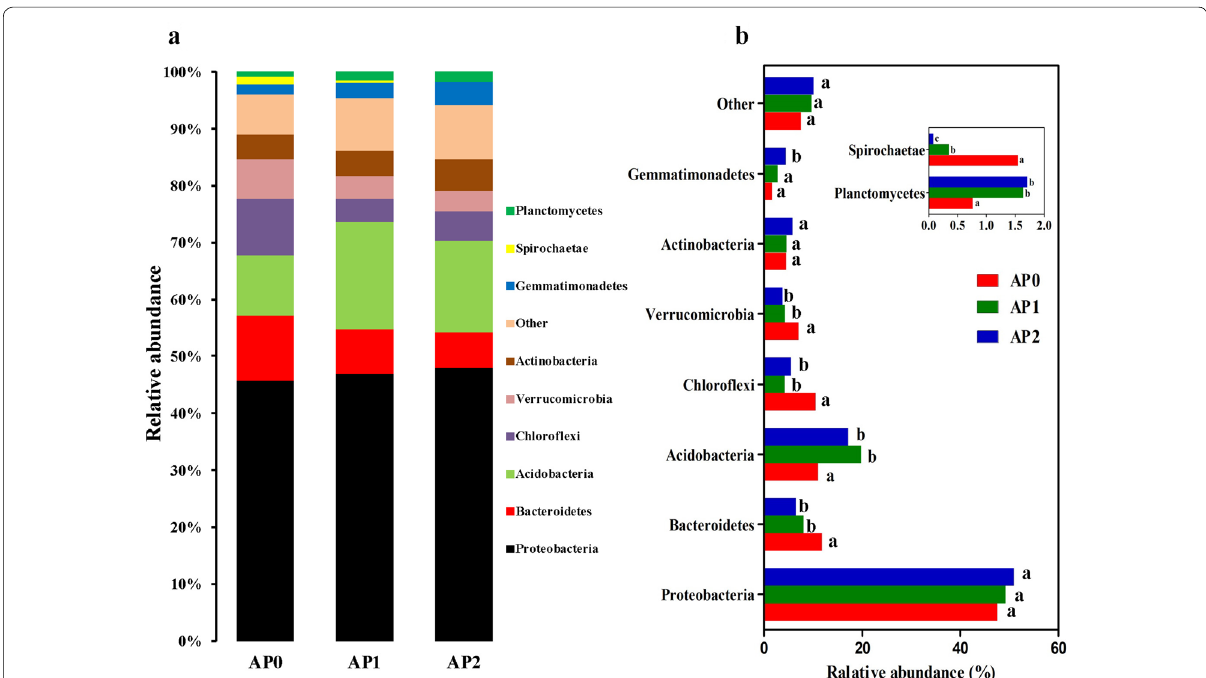
Fig. 4 Relative abundance of the dominant bacterial phyla in the soils continuously cropped Andrographis paniculata. a Bacterial community composition at the phylum level. b Variations of bacterial community composition. Only phyla with more than 1% relative abundance in at least one sample were shown and different letters mark significant difference at P < 0.05. The “Other” group contained the phyla with relative abundance < 1%. AP0, AP1 and AP2 represent soils with continuously cropping histories of A. paniculata for 0, 1 and 2